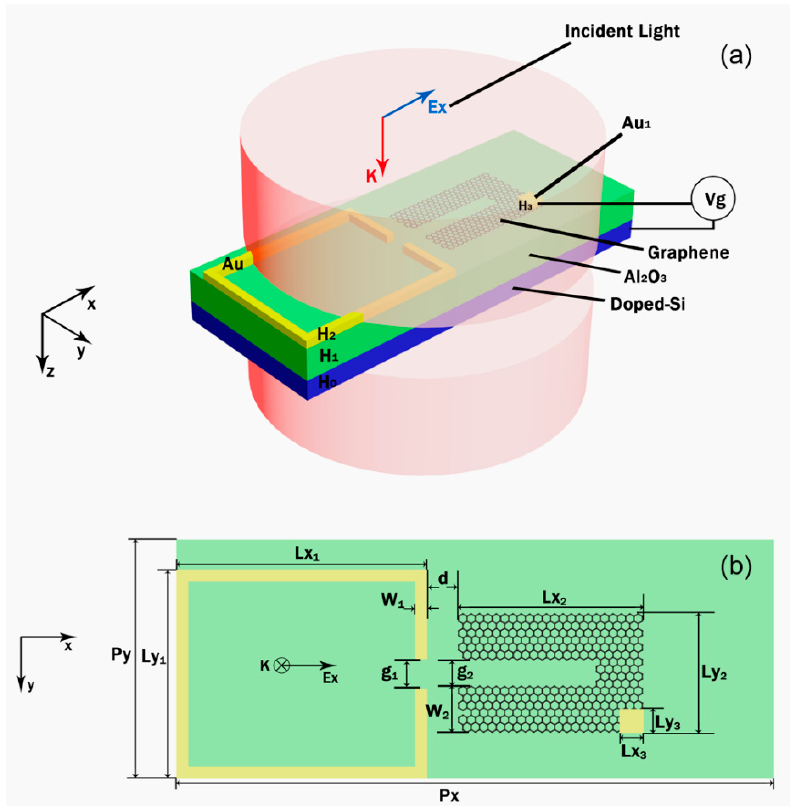
Figure 1. ( a ) Schematic diagram of the plasmonic metamaterial unit cell consists of a graphene split-ring and a gold split-ring. ( b ) Top view of metamaterial structure. The periods of the y and x direction are Py = 0.22 μ m, Px = 1.34 μ m, respectively. The distance between the graphene split-ring and the gold split-ring is d and the gaps of the gold split-ring and the graphene split-ring are g 1 = 8 nm, g 2 = 20 nm, respectively. The width of the gold split-ring and the graphene split-ring are W 1 = 12 nm, W 2 = 43 nm. The length of the gold split-ring in the y and x direction are Ly 1 = 200 nm, Lx 1 = 262 nm, respectively; and the length of the graphene split-ring in the y and x direction are Ly 2 = 106 nm, Lx 2 = 104 nm, respectively. The thickness of doped silicon, Al 2 O 3 and Au are set as H 0 = 10 nm, H 1 = 40 nm and H 2 = 4 nm, respectively. V g is the applied voltage and both the Au 1 and doped silicon are served as electrodes to apply voltages to the graphene split-ring. The thickness of the Au 1 is H 3 = 4 nm and its width (Ly 3 ) and length (Lx 3 ) are set as 10 nm.